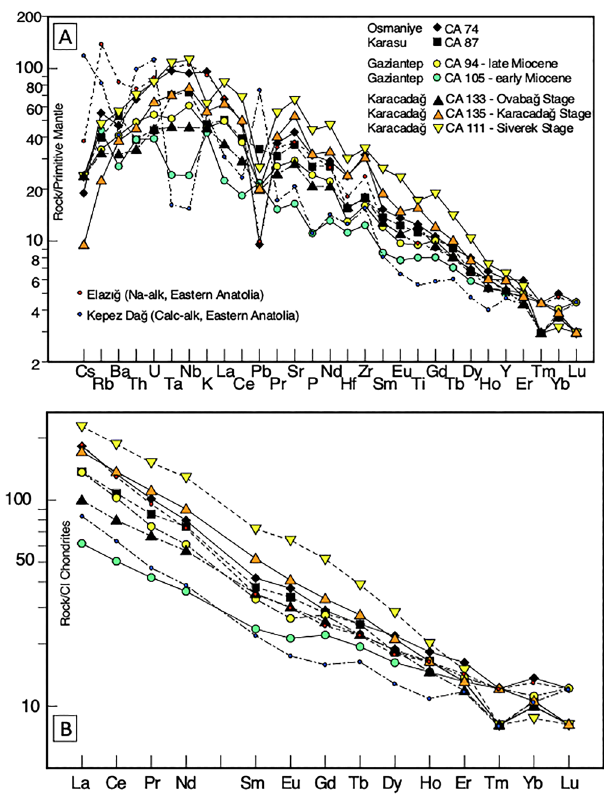
Figure 2. Distribution of incompatible trace element and Rare Earth Element (REE) of selected alkali basalts. ( A ) Primitive Mantle-normalised diagrams for selected samples. ( B ) Chondrite-normalised REE diagrams for the same samples. Na-alkaline basalt from Elazığ in Eastern Anatolia 25 and a subduction-related basaltic andesite from Kepez Dağ volcanic complex in Central-Eastern Anatolia 24 are reported for comparative purposes. Primitive Mantle and Chondrite normalisation factors from McDonough and Sun 26